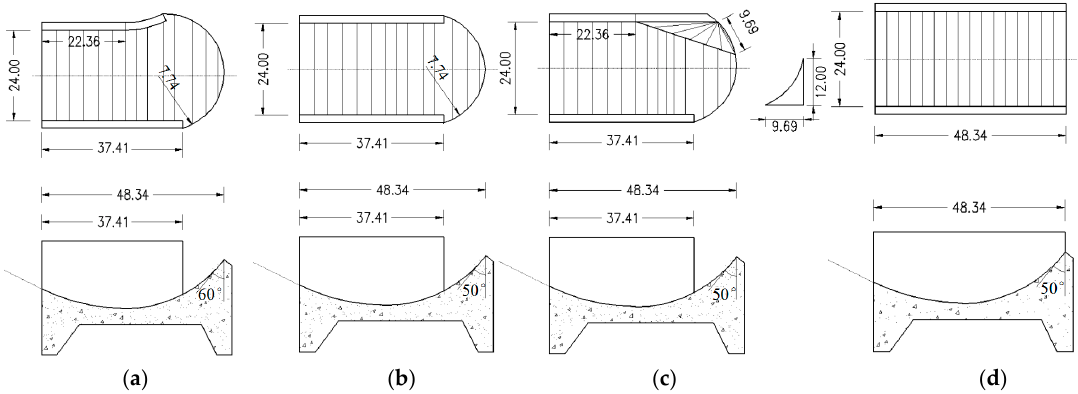
Figure 2. Flip bucket types of the physical model test: ( a ) shape 1; ( b ) shape 2; ( c ) shape 3; ( d ) shape 4; (units: cm).